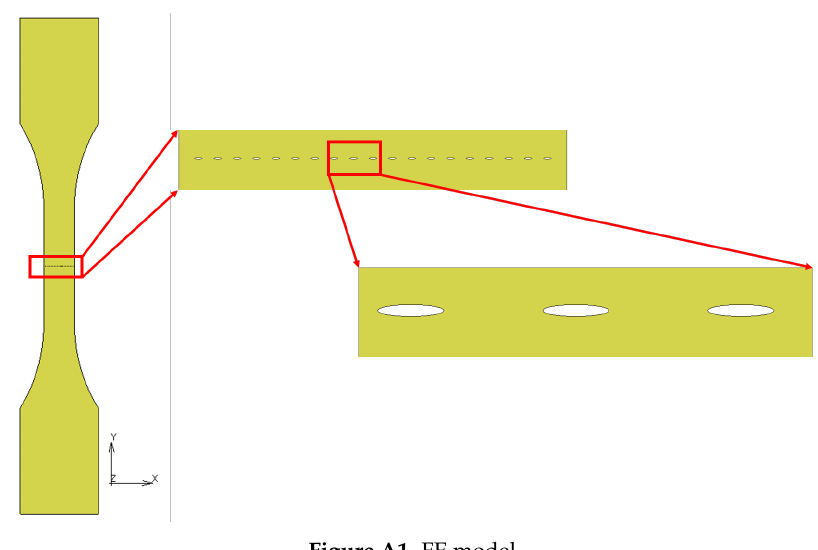
Figure A1. FE model.